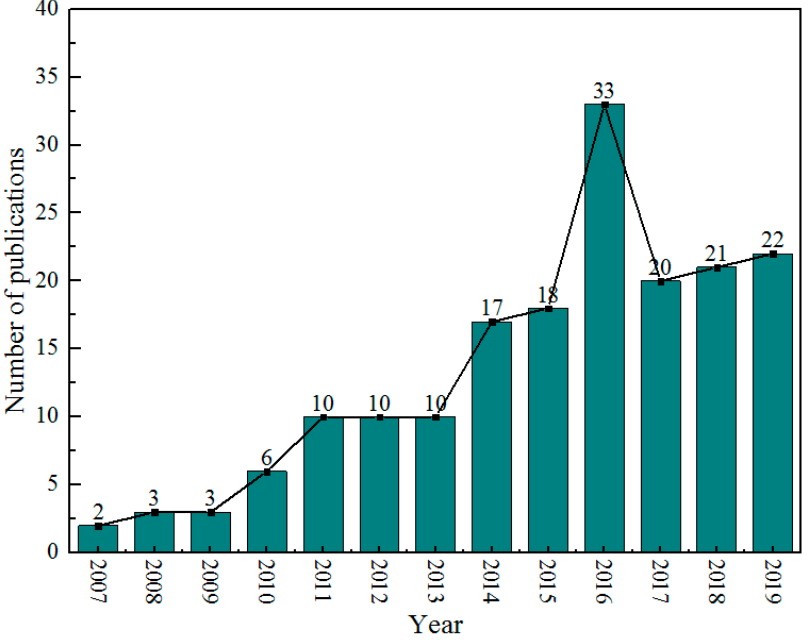
Figure 1. Output of publications during 2007–2019.